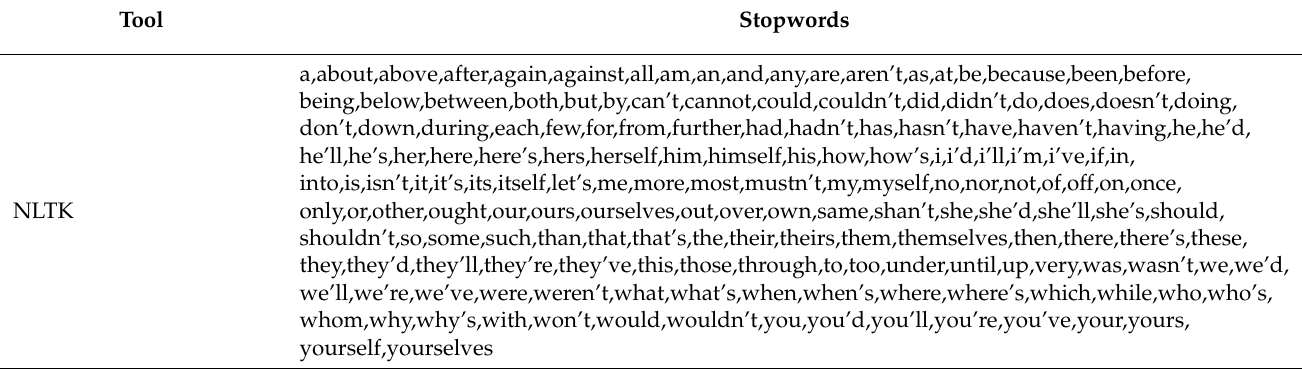
Table 1. Stopwords obtained after using the